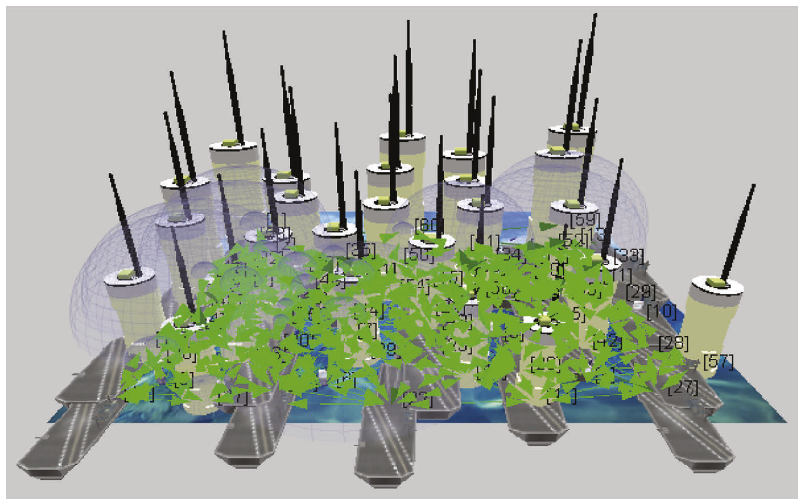
Figure 6: Runtime proposed scenario of underwater wireless communication with various nodes in 3D-visualization.